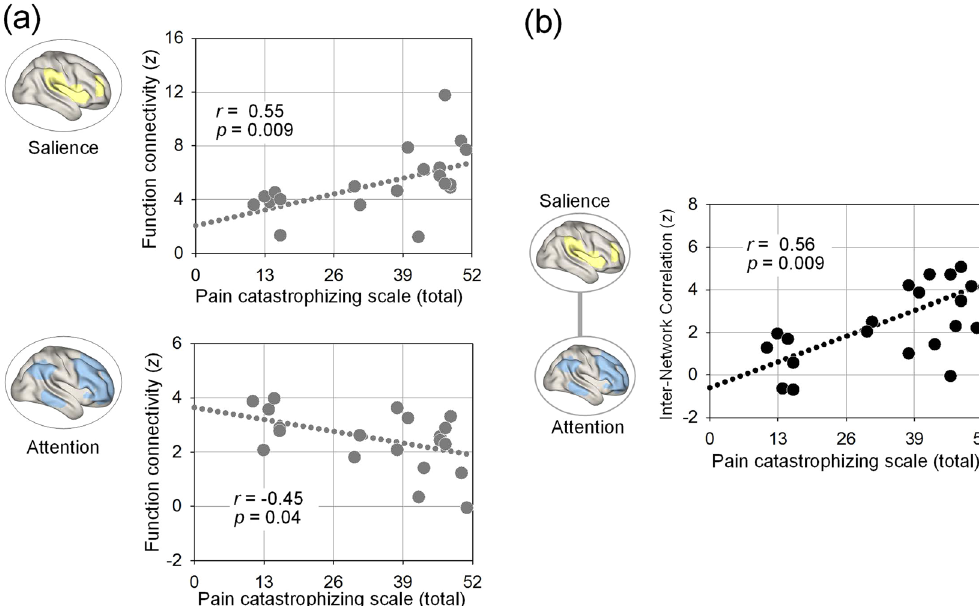
Figure 3. Correlations between the total scores on the Pain Catastrophizing Scale (PCS) in individuals with CRPS and functional connectivity in brain networks. (a) Scatter plots and regression lines between PCS scores and intra-network functional connectivity in the salience and attention networks. A significant positive correlation between PCS scores and enhanced intra-network functional connectivity in the salience, while a significant negative correlation between PCS scores and functional connectivity in the attention network were observed in individuals with CRPS. (b) Scatter plot and regression line between PCS scores and inter-network functional connectivity. A significant positive correlation was observed between PCS scores and enhanced functional coupling between the attention and salience networks in individuals with CRPS. CRPS, complex regional pain